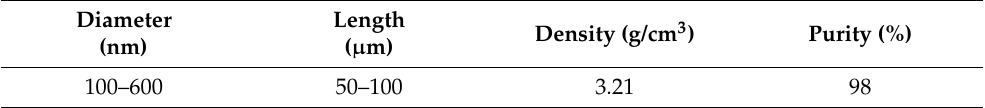
Table 3. Properties of SiC nanowires.